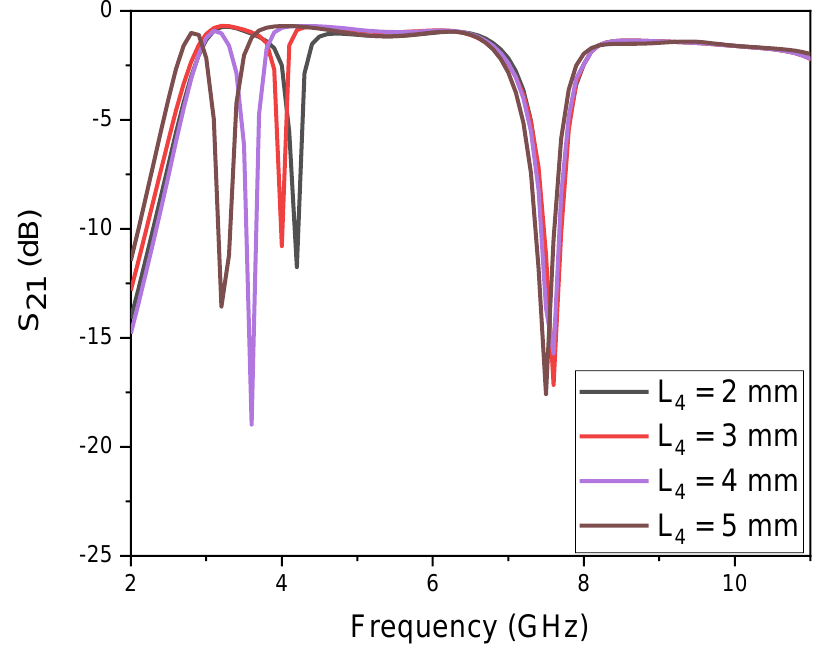
Figure 12. S 21 plot of first band control with parameter L 4 .